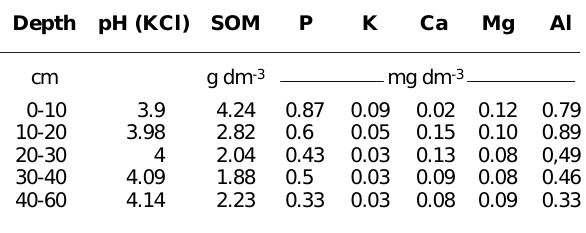
Depth pH (KCl) SOM P K Ca